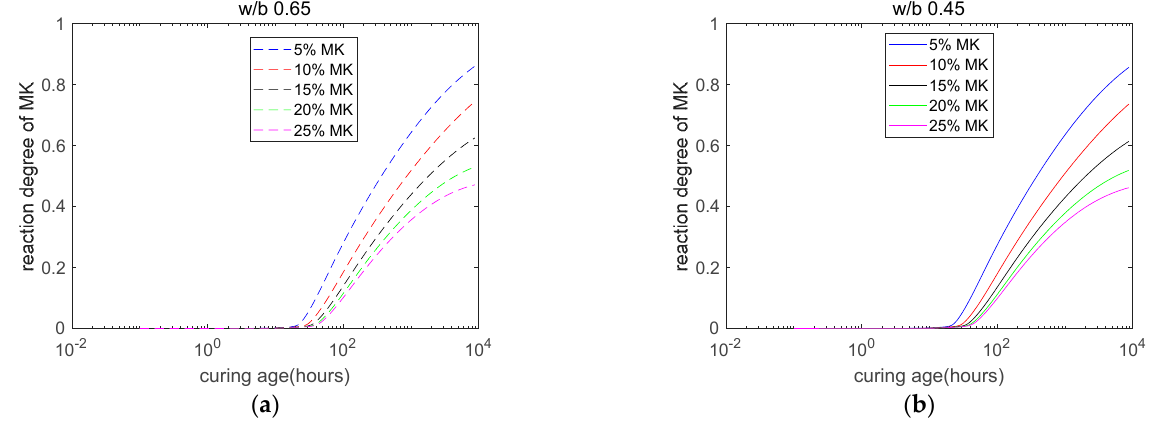
Figure 3. Degrees of reaction of metakaolin in cement–metakaolin blends. ( a ) reaction extent of metakaolin: water/binder ratio 0.65. ( b ) reaction extent of metakaolin: water/binder ratio 0.45.